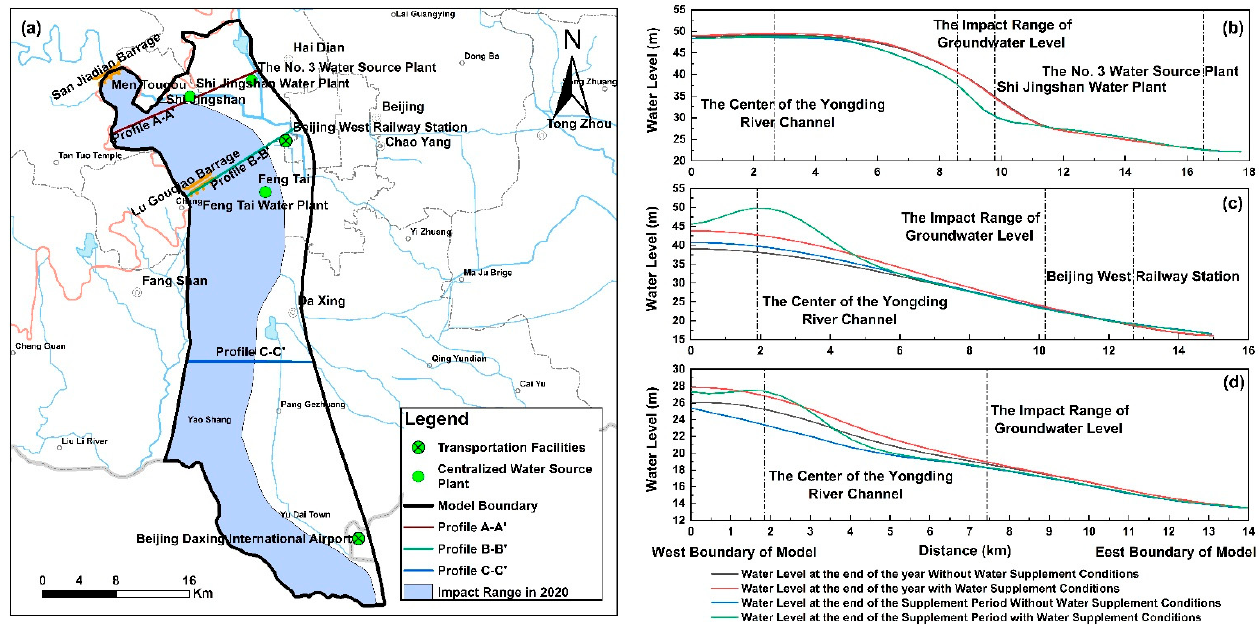
Figure 8. ( a ) Impact range of groundwater level restoration in the Yongding River supplement region in 2020. ( b ) Profile A–A’ water level change map for the upper reaches of the Yongding River. ( c ) Profile B–B’ water level change map for the middle reaches of the Yongding River. ( d ) Profile C–C’ water level change map for the lower reaches of the Yongding River.